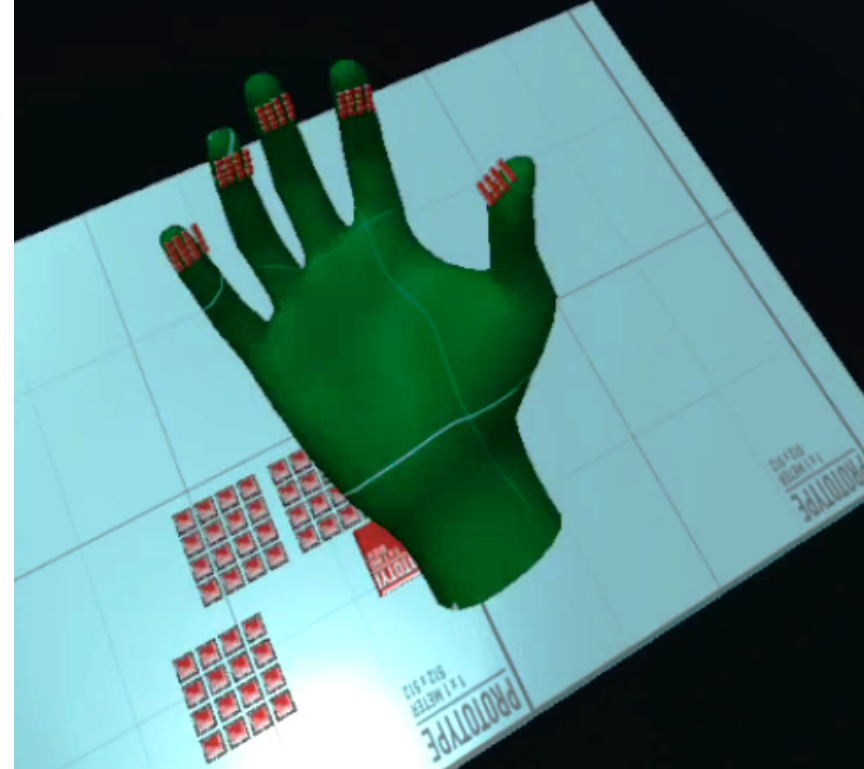
Figure 15. Scaling of the VR tactile actuators.